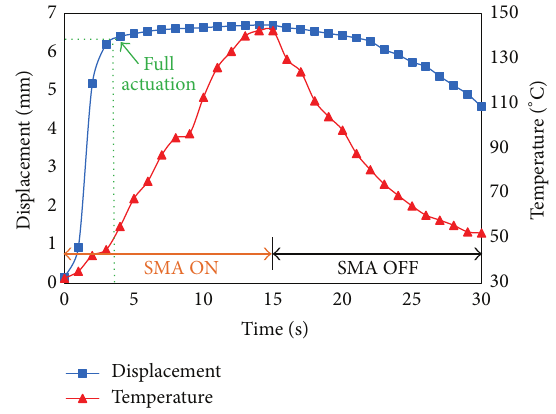
Figure 13: Temporal and thermal response of SMA actuator at PWM duty cycle of